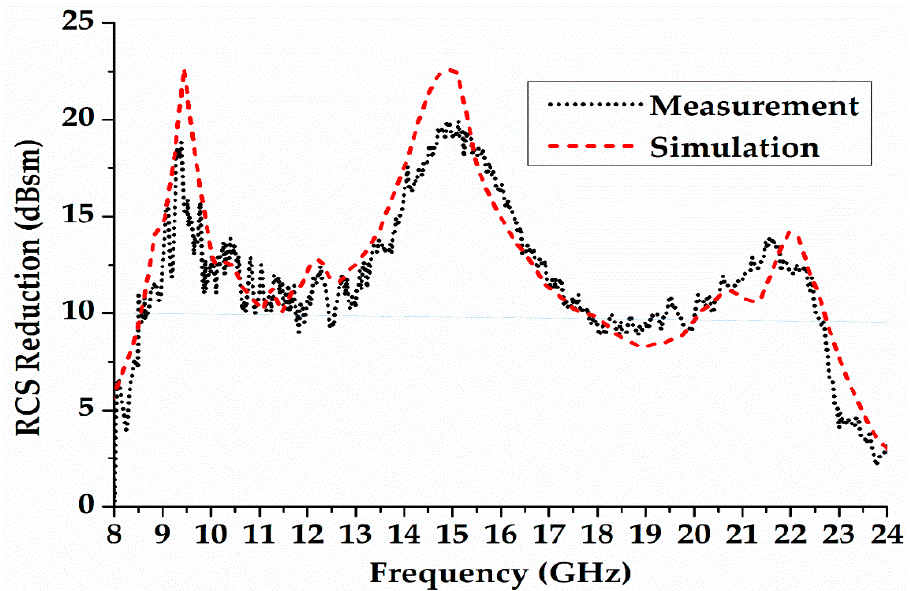
Figure 11. Measurement and Simulation Results of RCS Reduction.